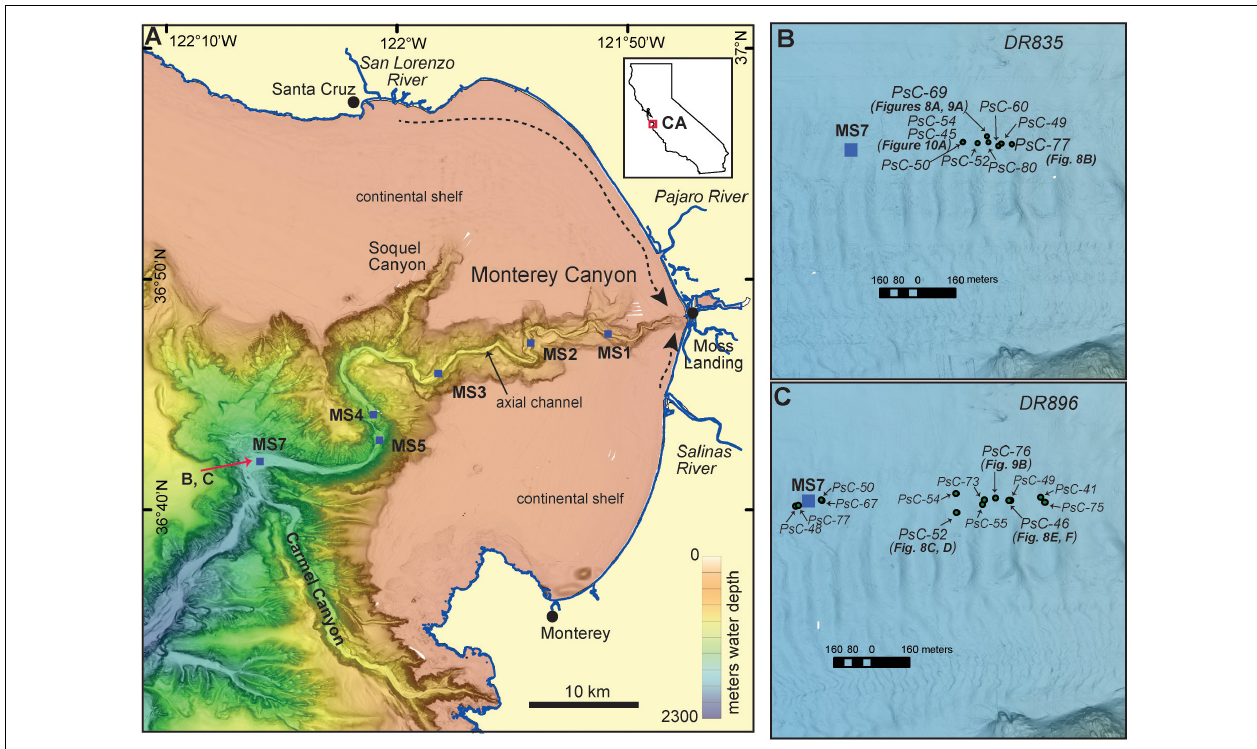
FIGURE 1 | Sample locations in Monterey Canyon, offshore central California. (A) Coordinated Canyon Experiment (CCE) moorings along Monterey Canyon axial channel (modified from Paull et al., 2018). Dashed arrows signify longshore transport of sand into Monterey Canyon. (B) Locations of remotely operate vehicle (ROV) pushcores from DR835, collected April 19, 2016 and plotted on Monterey Bay Aquarium Research Institute (MBARI) mapping autonomous underwater vehicle (AUV) 1-m lateral resolution slope-shaded multibeam bathymetry acquired on April 18, 2016. (C) Locations of ROV pushcores from DR896, collected October 19, 2016 and plotted on MBARI AUV 1-m lateral resolution slope-shaded multibeam bathymetry acquired on December 6,